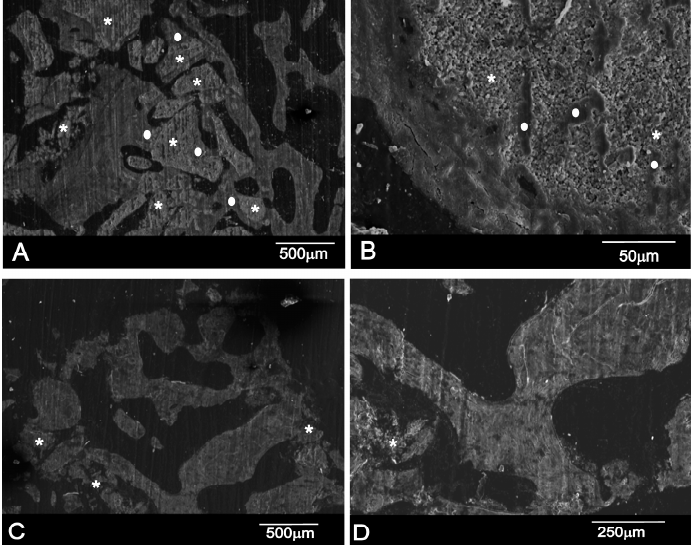
Figure 7. SEM-BSE of a resin-embedded bone section that contains bone and residual biomaterials: ( A , B ) the BBM material; and ( C , D ) the PBM material (* material particles as a result of the degradation process, and • new bone). Section of the bone retrieved from a patient’s maxillary sinus six months after sinus elevation.